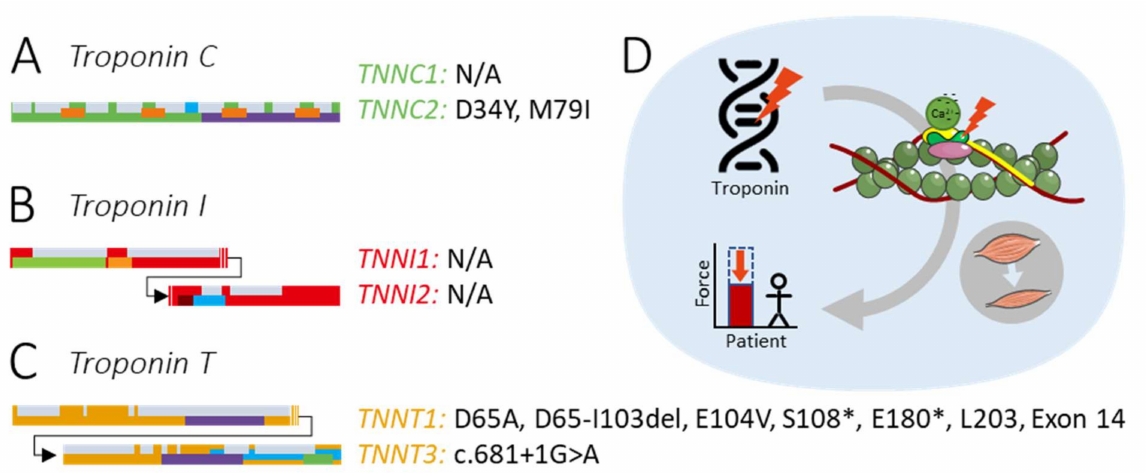
Figure 5. Summary figure. ( A ) Reported skeletal troponin C variants. ( B ) Reported skeletal troponin I variants. ( C ) Reported skeletal troponin T variants. ( D ) Variants in skeletal troponin-encoding genes cause a decrease of the Ca 2+ sensitivity and/or atrophy of skeletal muscle, which result in muscle weakness. The image of the thin filament is modified